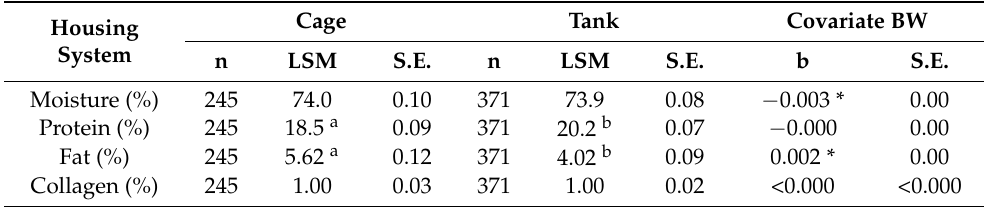
Table 4. Flesh composition (protein, moisture, fat, and collagen percentages) (least square means, LSM, ± standard error, S.E.), for meagre at 549 days post-hatching raised in two different environments.